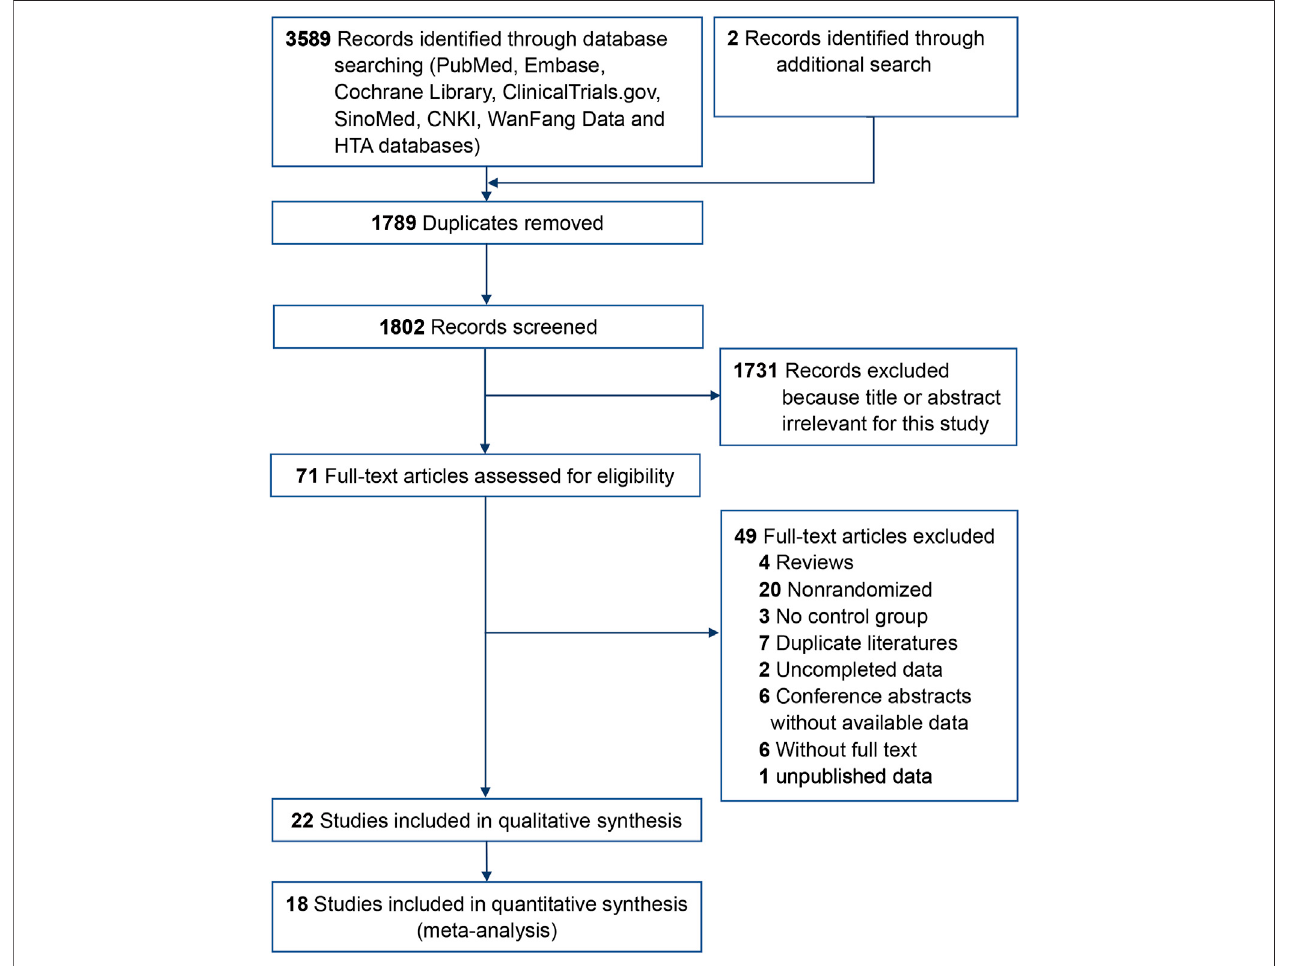
FIGURE 1 | Study selection fl